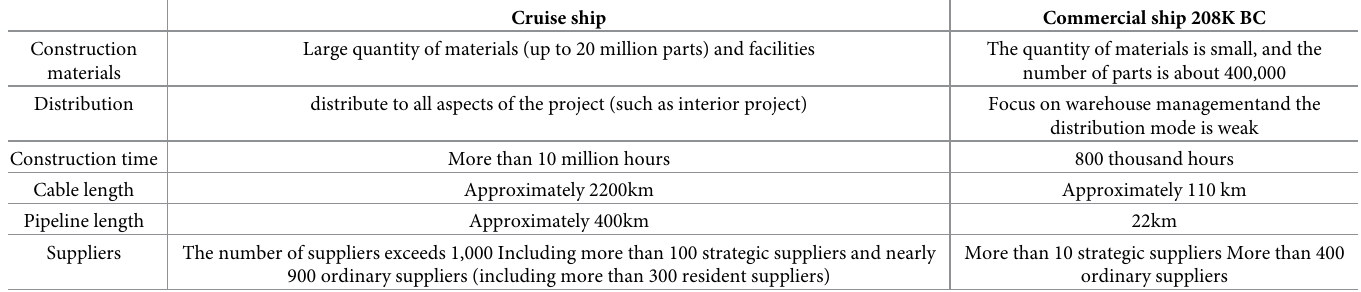
Table 1. Comparison between cruise ship and commercial